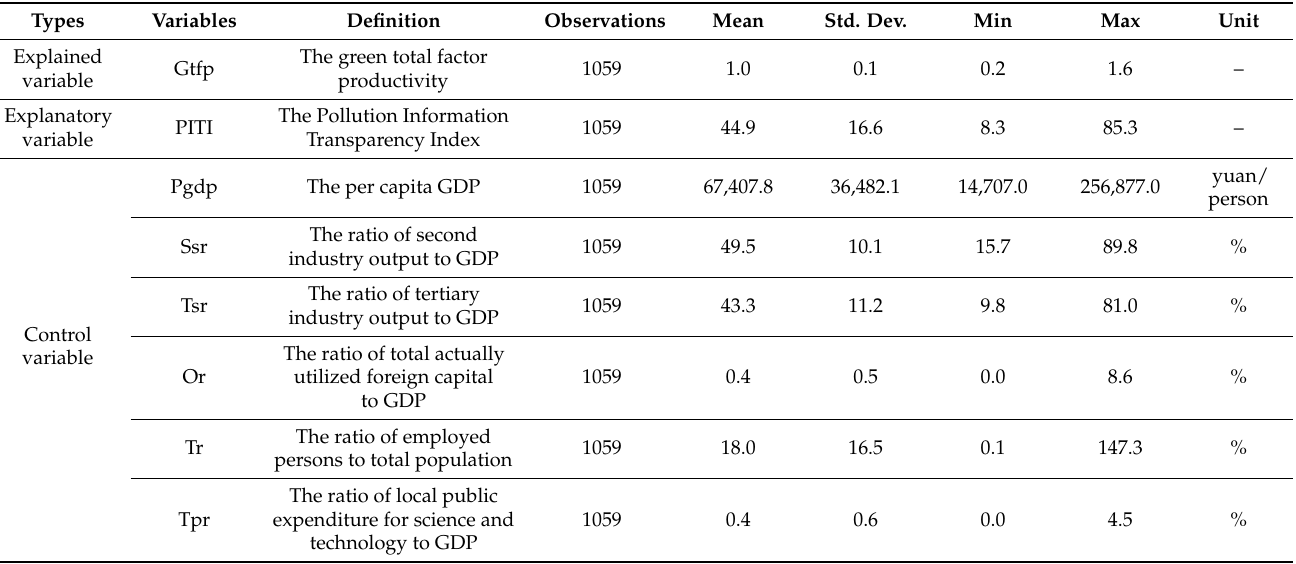
Table 2. The descriptive statistics of sample